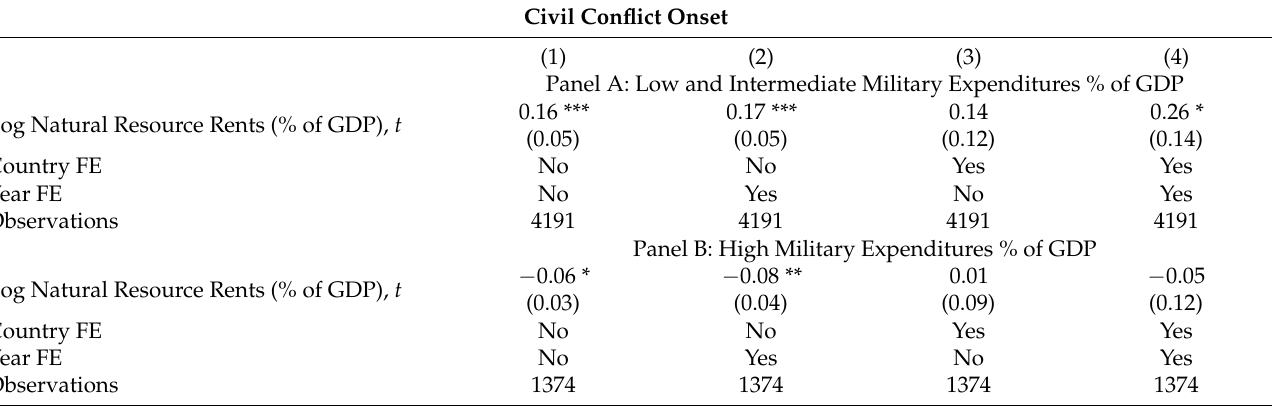
Table A3. Sample Split. Civil Conflict Onset Panel A: Low and Intermediate Military Expenditures % of GDP